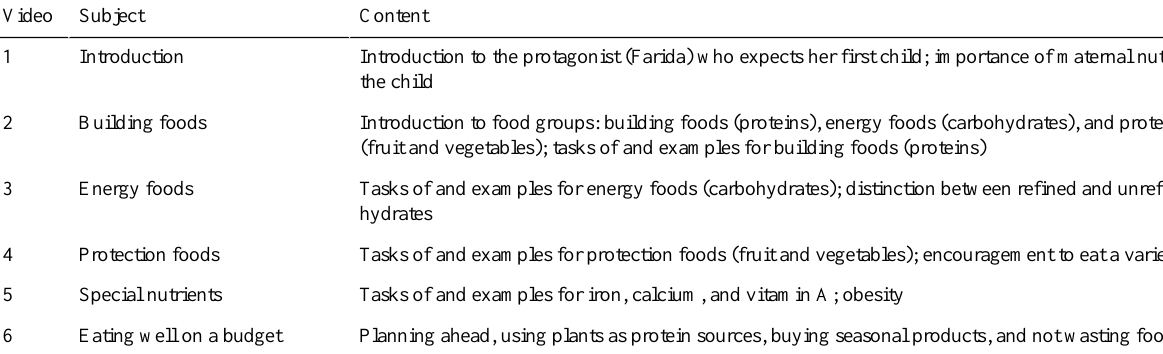
Table 1. Concept and content of South African videos related to maternal